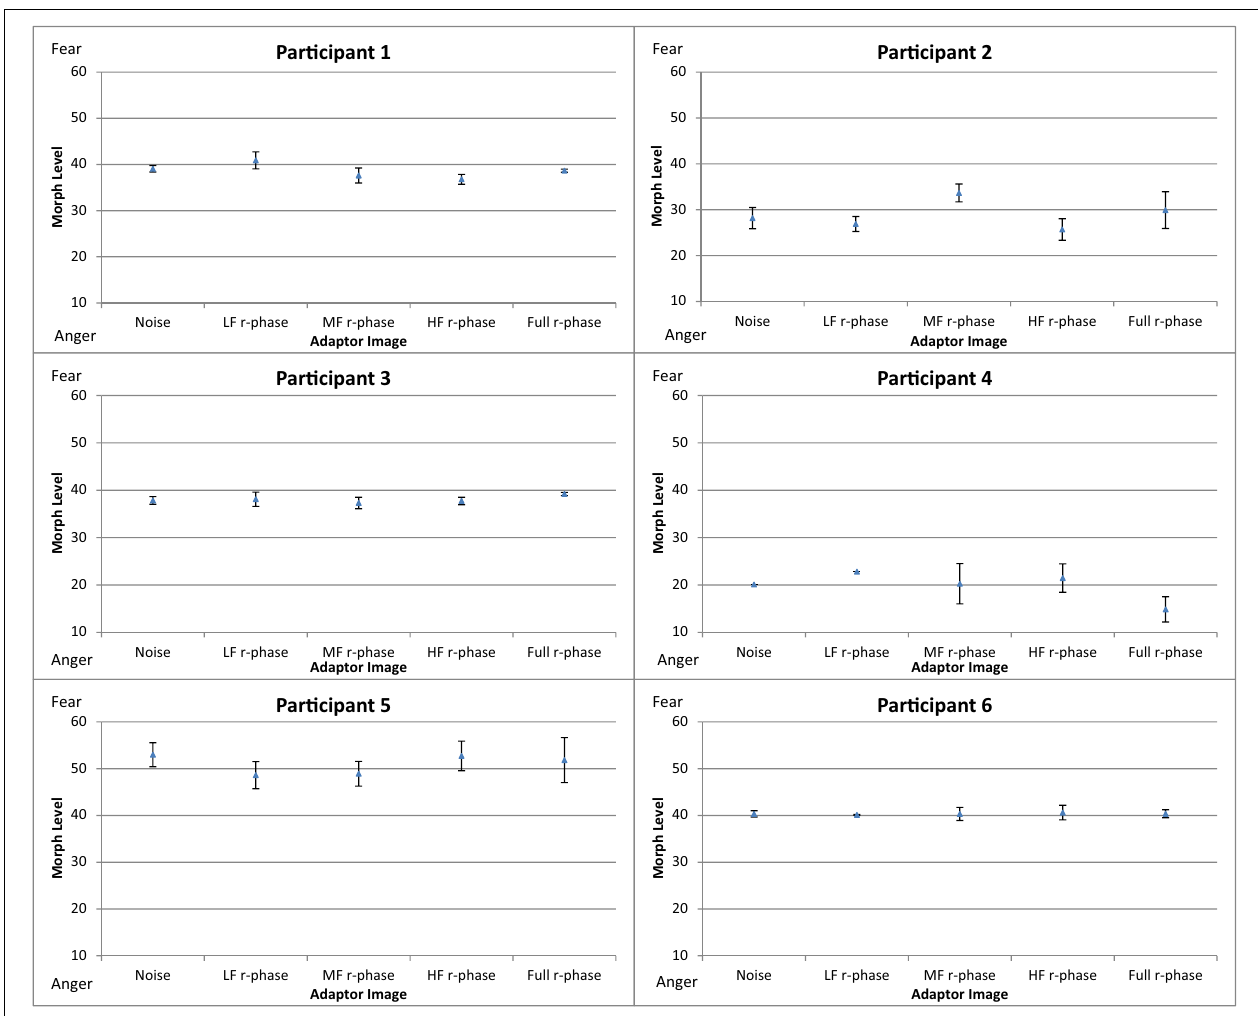
FIGURE 8 | Mean thresholds of morph level for the five conditions (white noise, LF random-phase, MF random-phase, HF random-phase, and full-bandwidth random-phase) for participants in Experiment 3 . Error bars show ± 1 standard error of the mean.